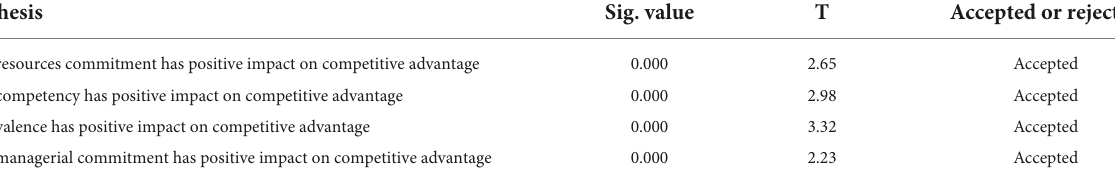
TABLE 6 Hypothesis assessment